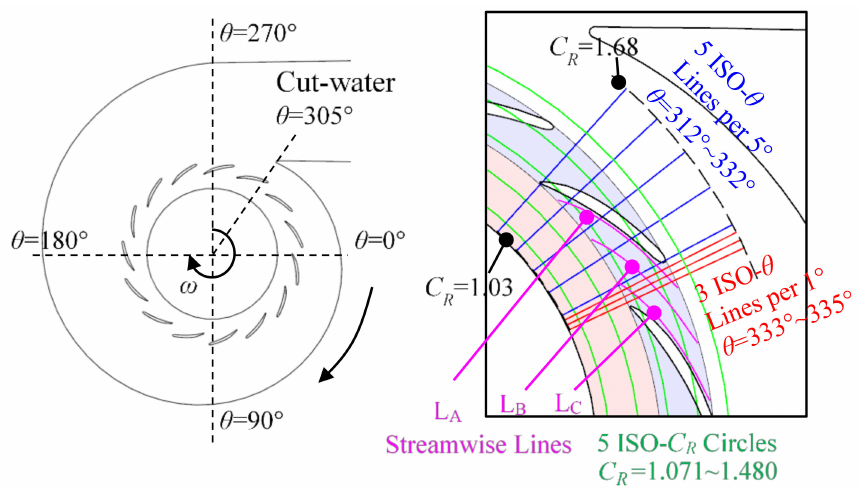
Figure 16. Reference angle and positions for analyzing the detailed distribution of amplitude on the Z = 0